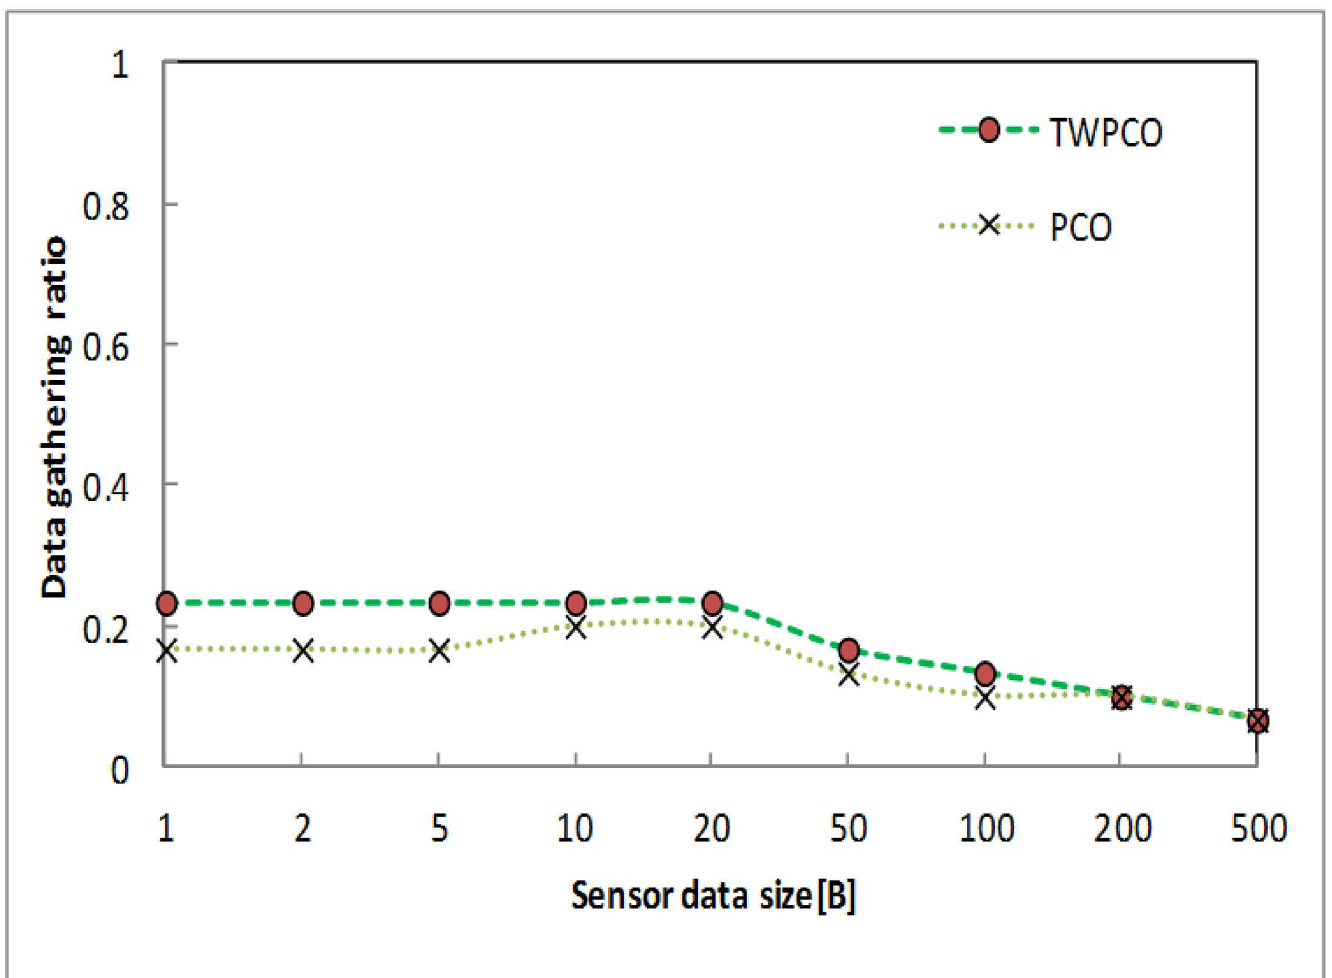
Fig 19. Data gathering ratio based on data size and added data